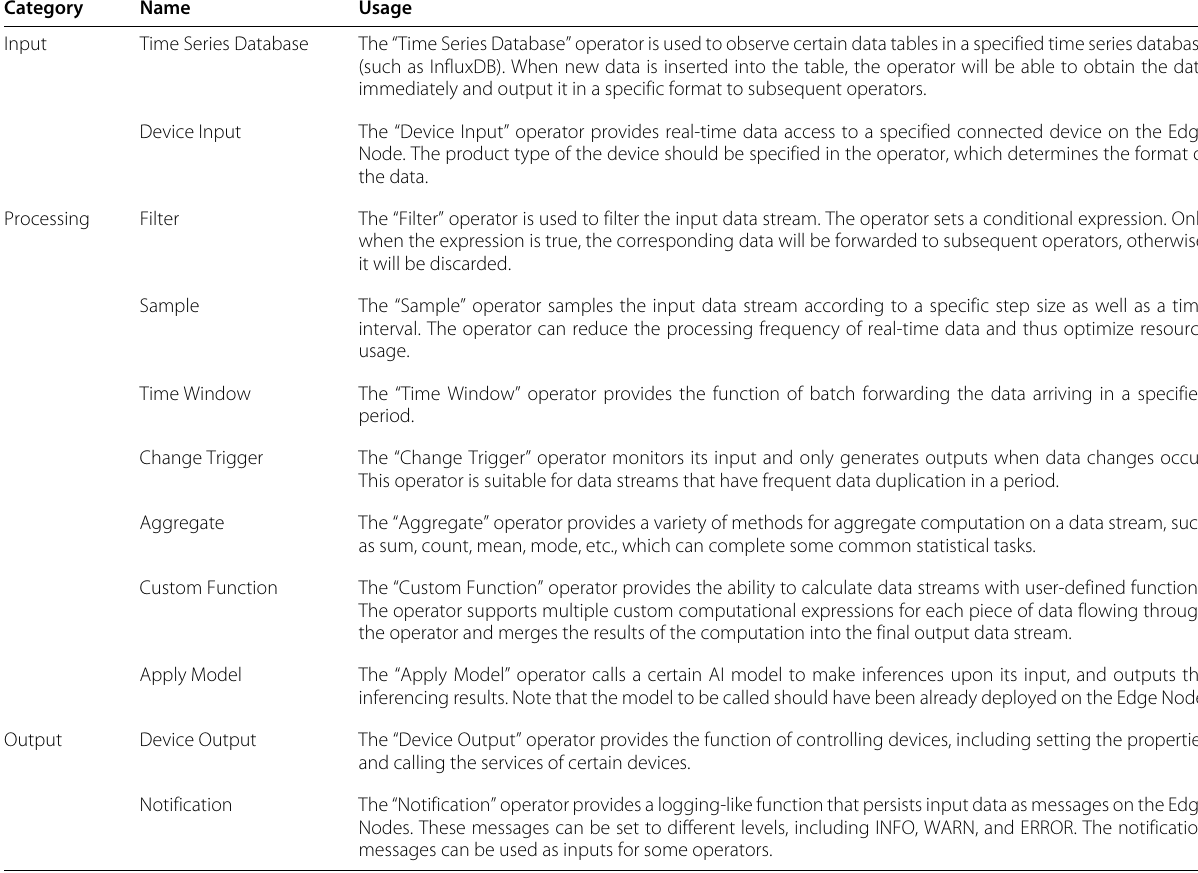
Table 1 Pre-implemented operators for structured data (partial.)